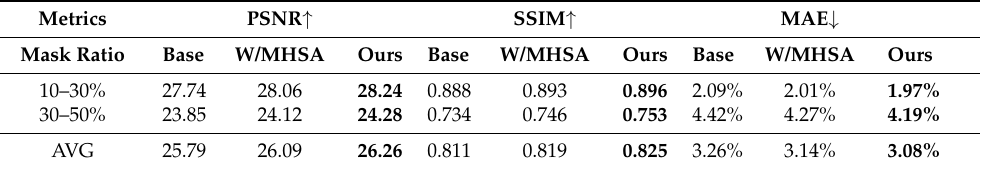
Table 7. Effectiveness of our Ada-attention on the AID dataset.